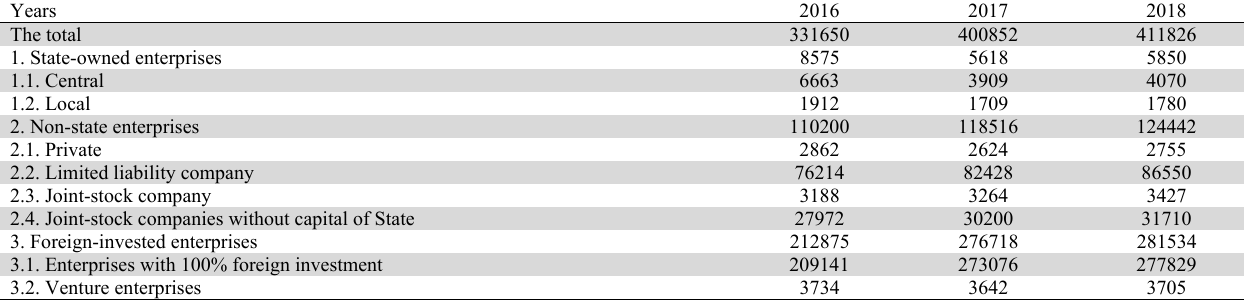
Scale of employees working in enterprises in Bac Ninh province (Unit: People)